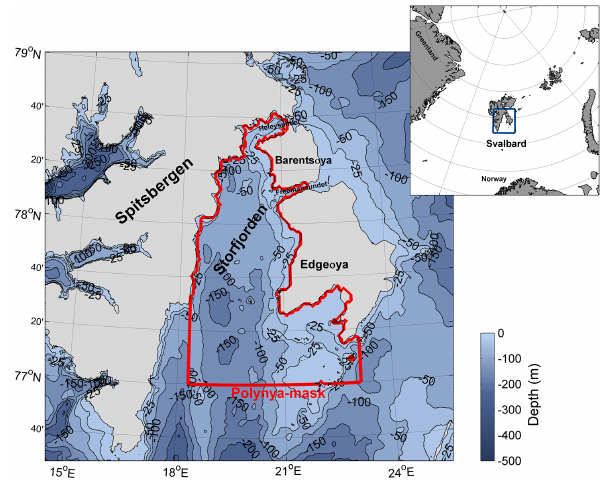
Figure 1. Map of the Svalbard archipelago in western Barents Sea. The study region is located in Storfjorden, which is surrounded by the main island Spitsbergen in the west and Barentsøya/Edgeøya in the east. The applied polynya mask is marked in red, enclosing the Storfjorden basin north of the sill at 77 ◦ N. Bathymetric data by Jakobsson et al. (2012) (IBCAO